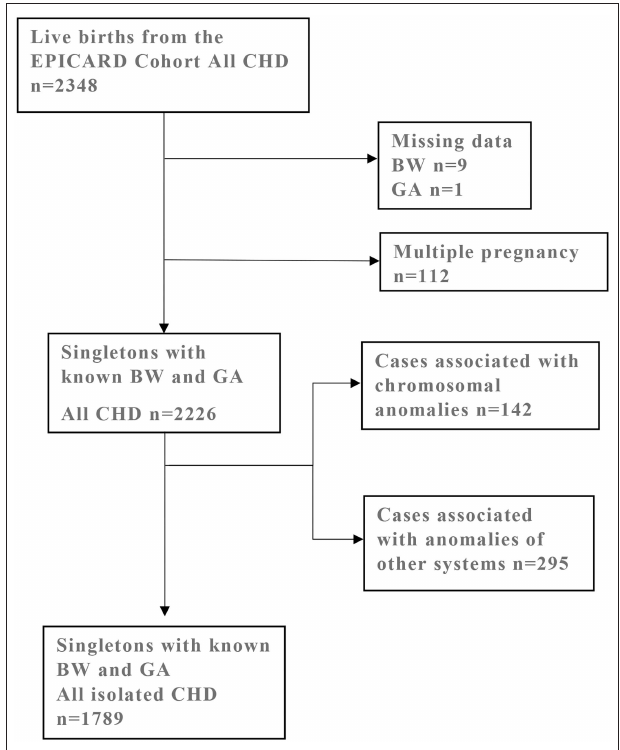
FIGURE 1 | Selection of study population from the EPICARD Cohort of live birth born with all CHD. CHD, congenital heart defects; BW, birth weight; GA, gestational